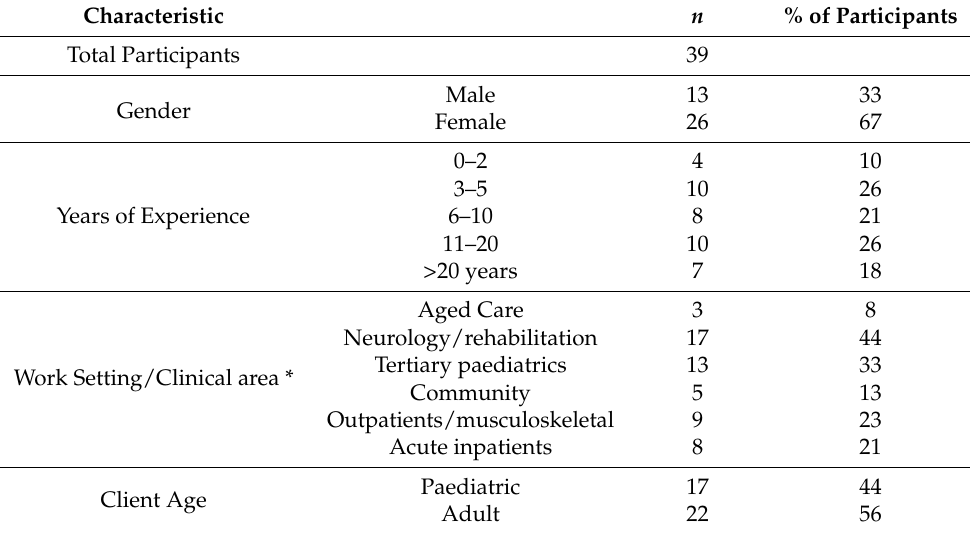
Table 1. Participant Characteristics. Characteristic n % of Participants Total